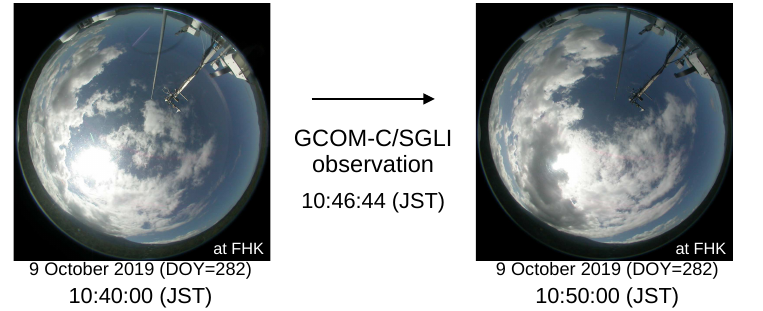
Figure 12. The spatial distribution of PRI satellite and CCI satellite on 9 October 2019 (DOY = 282) around FHK. The cyan circles in each figure indicate the location of FHK. The red rectangle in ( a ) represents the range of ( b – d ). ( a ) shows the true color image of GCOM-C/SGLI. ( b ) shows the true color image, ( c ) shows PRI satellite , and ( d ) shows CCI satellite . ( a , b ) are not screened with the QA flag and ( c , d ) are screened with the QA flag. The black area represents where the RSRF product was unavailable, and the white area represents the screened area with the QA flag.